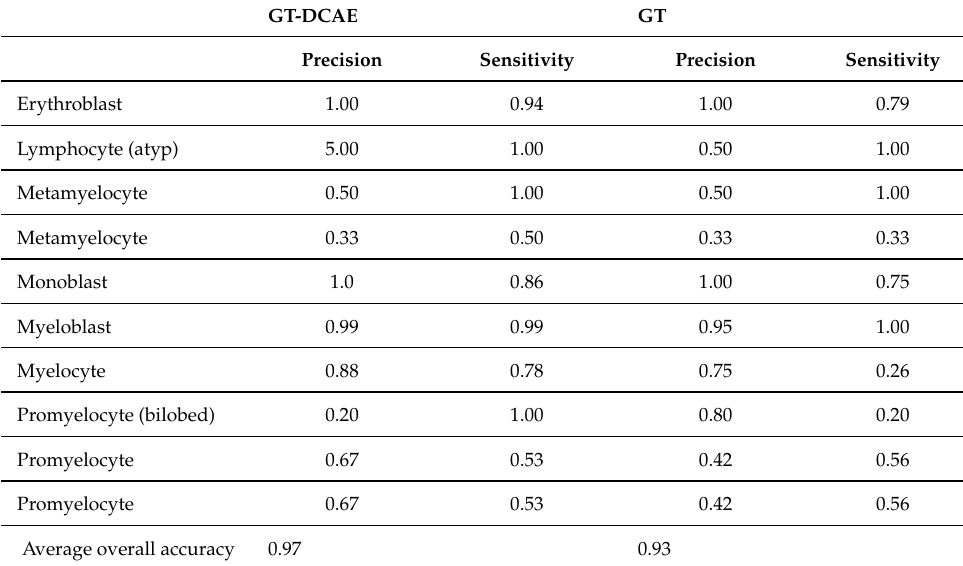
Table 4. GT-DCAE and GT augmentation approaches based on a two-stage DCAE-CNN model